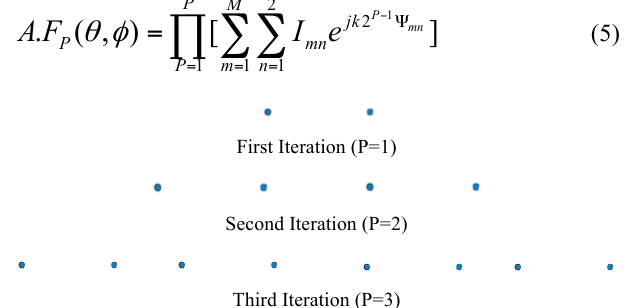
Figure 3. First three iterations of two element linear fractal array antenna for an expansion factor of two